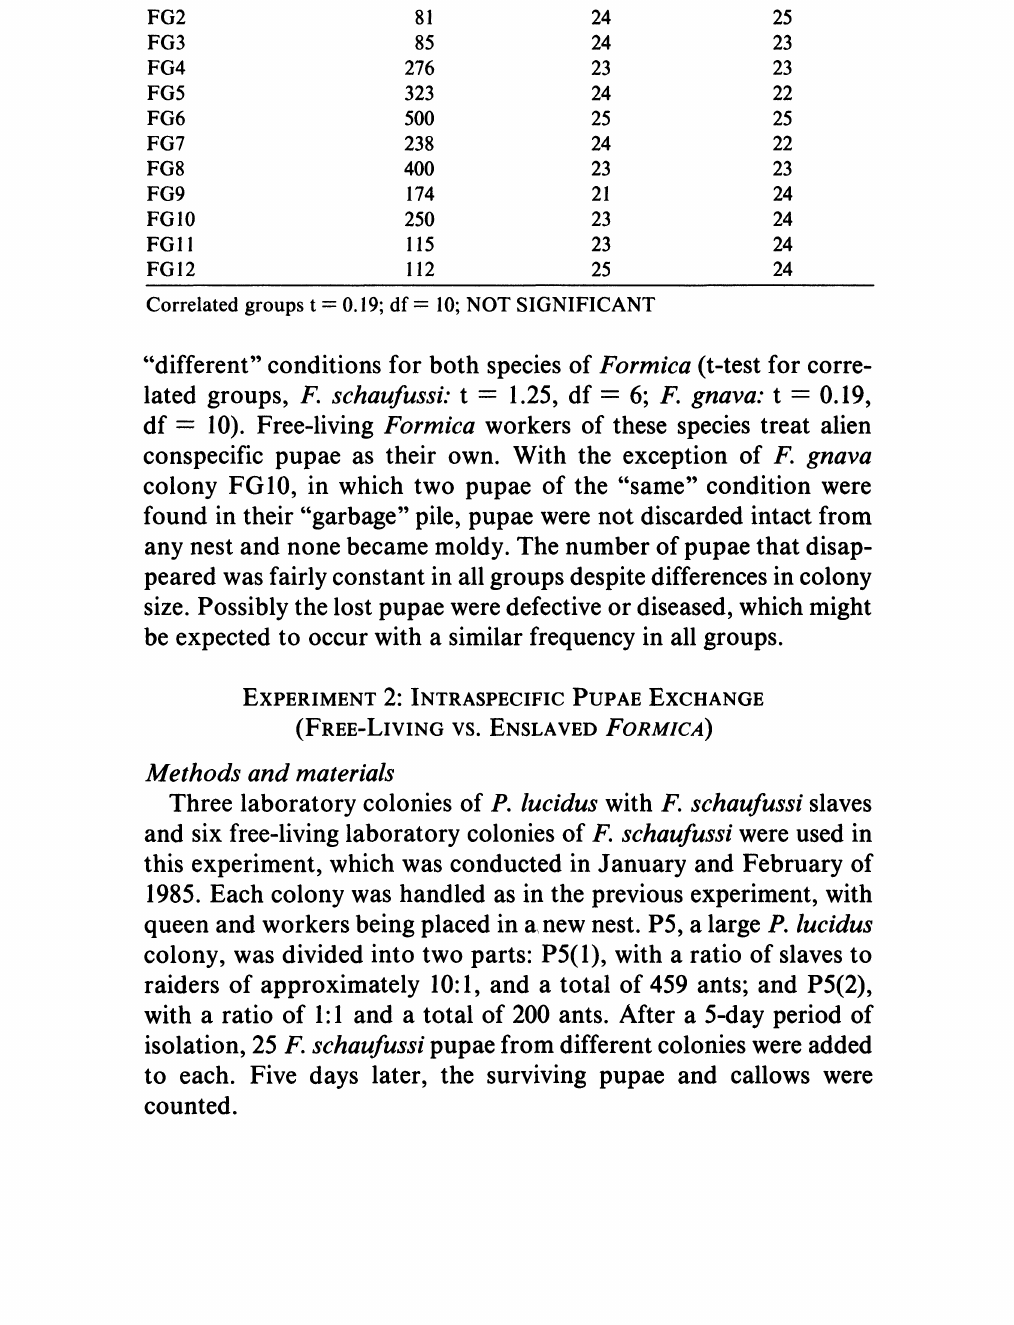
Surviving Pupae